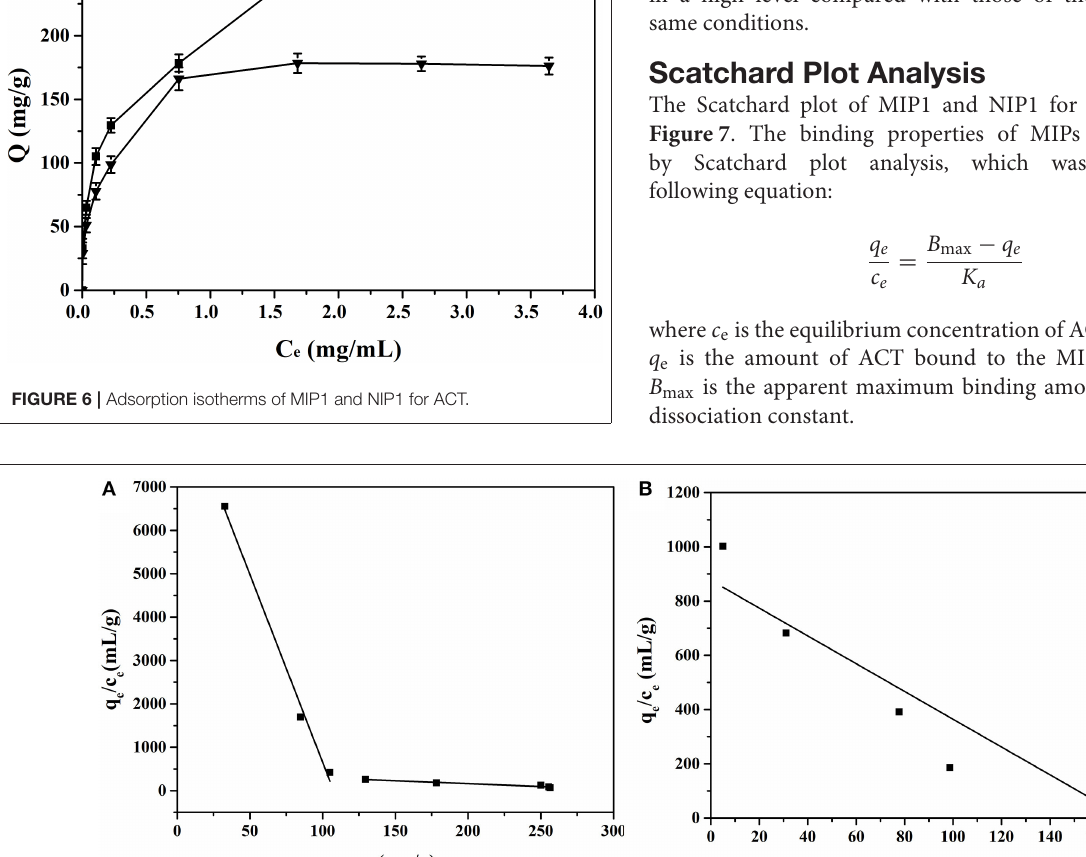
Frontiers in Chemistry |